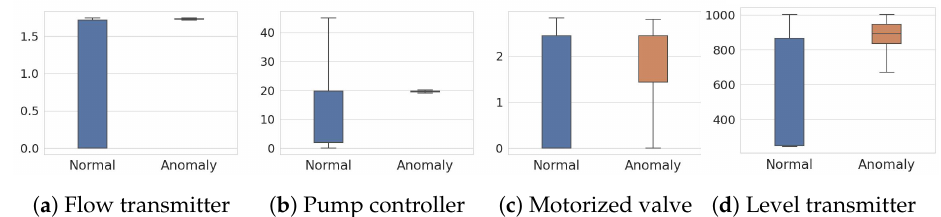
Figure 4. Box plots of normal and anomaly features in the SWaT dataset.